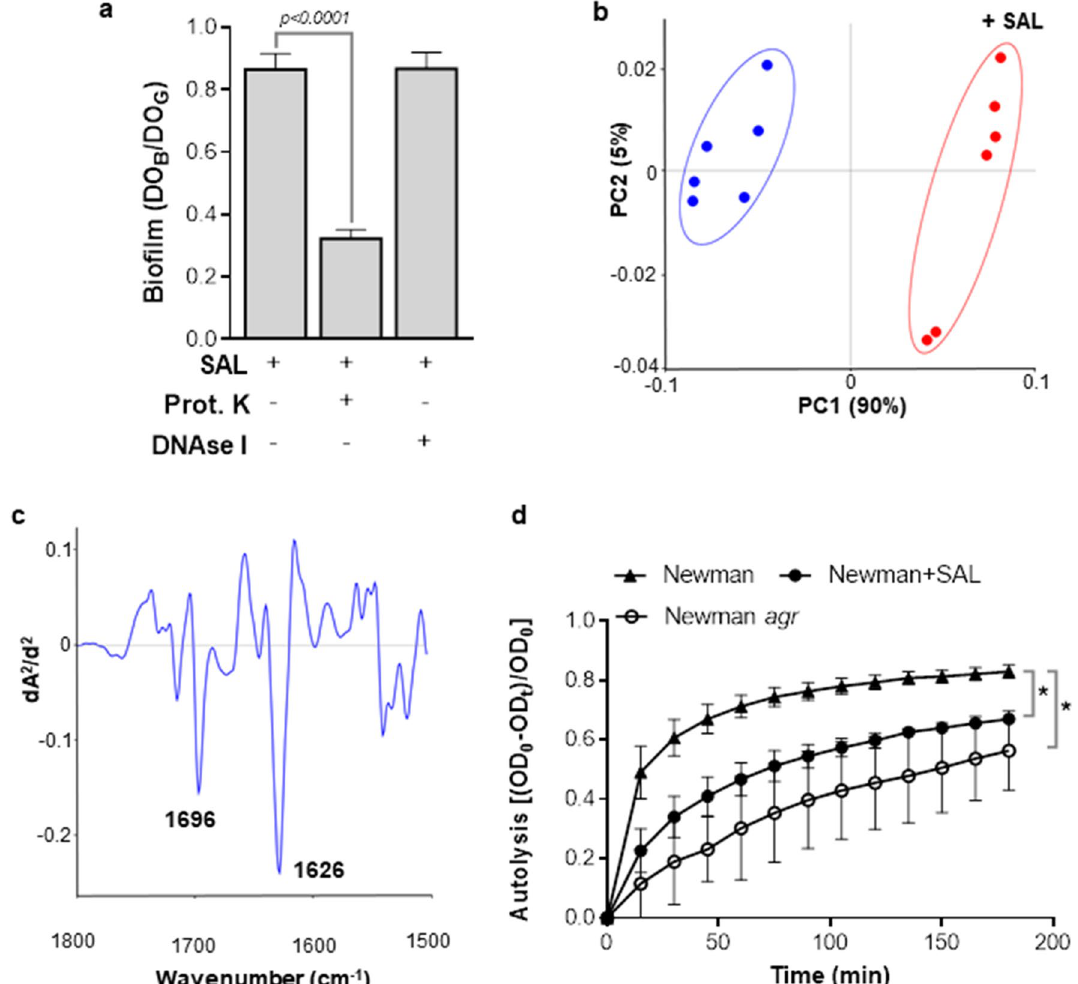
Figure 3. SAL alters the extracellular matrix components and autolysis. ( a ) Treatments with proteinase K (prot. K) or DNAse I of Newman biofilms formed for 24 h with 2 mM of SAL. Biofilm formation values correspond to the OD 595 of crystal violet (OD B ) measured relative to the final culture density (OD G ) after 24 h incubation. Each bar represents the mean ± SEM of 6–8 wells from 3 to 4 independent experiments. Statistical analysis was performed with the Mann–Whitney test. ( b ) Principal component analysis (PCA) was carried out using the second derivative of vector normalized FTIR spectra in the range corresponding to amide bonds (1500– 1800 cm −1 ) recorded from Newman biofilms. Biofilms were formed in TSBg with 2 mM of SAL during 24 h (red symbols) or without SAL (blue symbols). Different groups were indicated by ellipses in the figure. The relative contribution of each principal component is indicated in parenthesis. (c) Loading plot of SAL effect on S. aureus biofilm in the spectral region for protein constituents (1800–1500 cm −1 ). Spectral changes at 1626 cm −1 and 1696 cm −1 are related to alterations in the protein’s β-sheet conformation as well as anti-parallel pleated sheets and β-turn structures, respectively. (d) The Newman and Newman agr strain cultures were grown in TSBg with or without 2 mM of SAL to exponential phase. Bacterial lysis mediated by Triton X-100 was measured spectrophotometrically as a decrease in OD 600 over time. Autolysis was defined as Eq. 1. The curves represent 2 independent experiments, with significant changes in comparisons: control vs SAL treatment and wild type vs agr mutant, denoted with asterisks ( t-